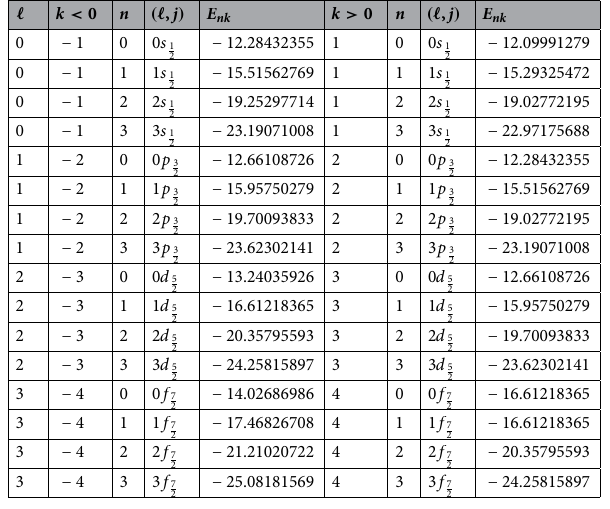
Table 6. Numerical values for pseudospin symmetry energies for A .